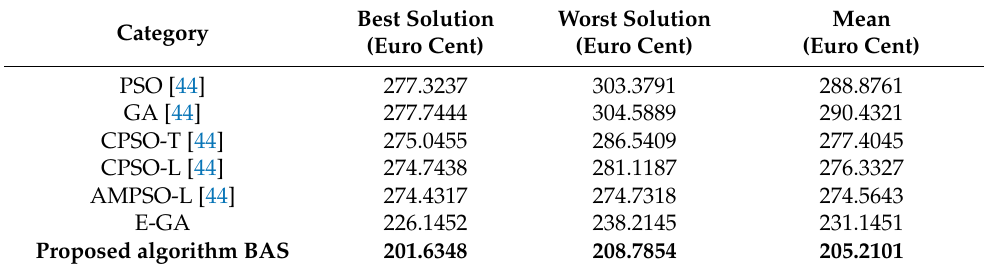
Table 5. Comparison of the cost of generation for various algorithms corresponding to Scenario 1.